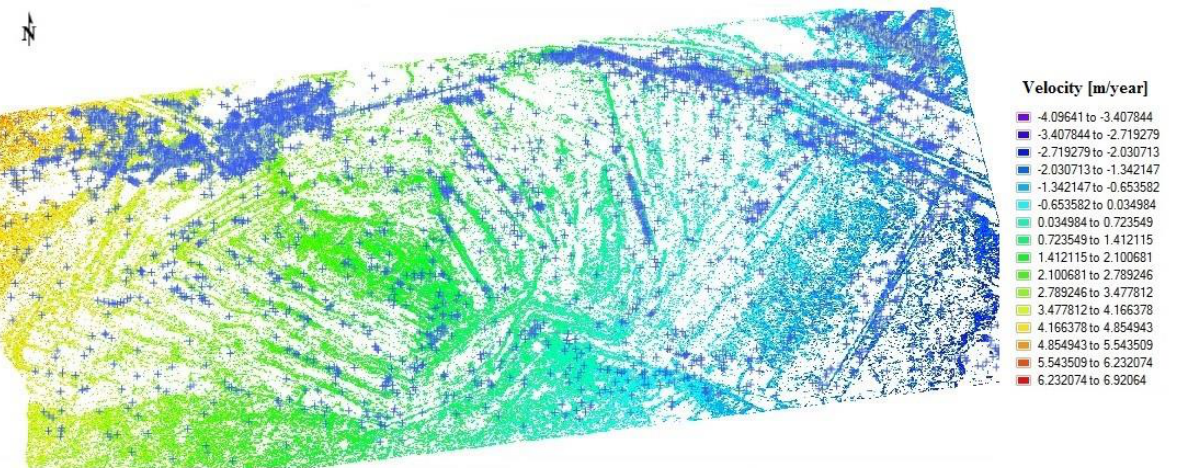
Figure 6. Speckle tracking map in LOS direction superposed with PS points. ©DLR,